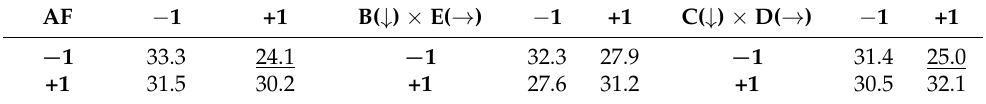
Table 15. Analysis of the effect of interactions AF + BE + CD. Wear in zone III at 350 ◦ C (mg).